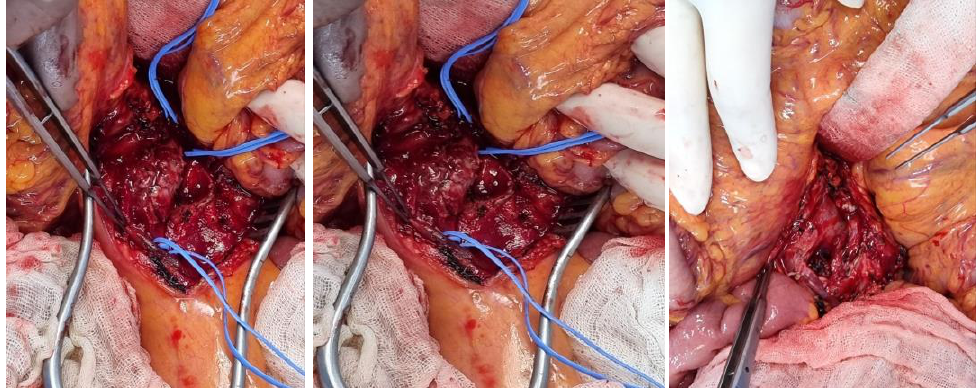
Figure 5. SMA mycotic aneurysm operation room finding. The first two images are prior to excision with pus, and the last image is after the excision.